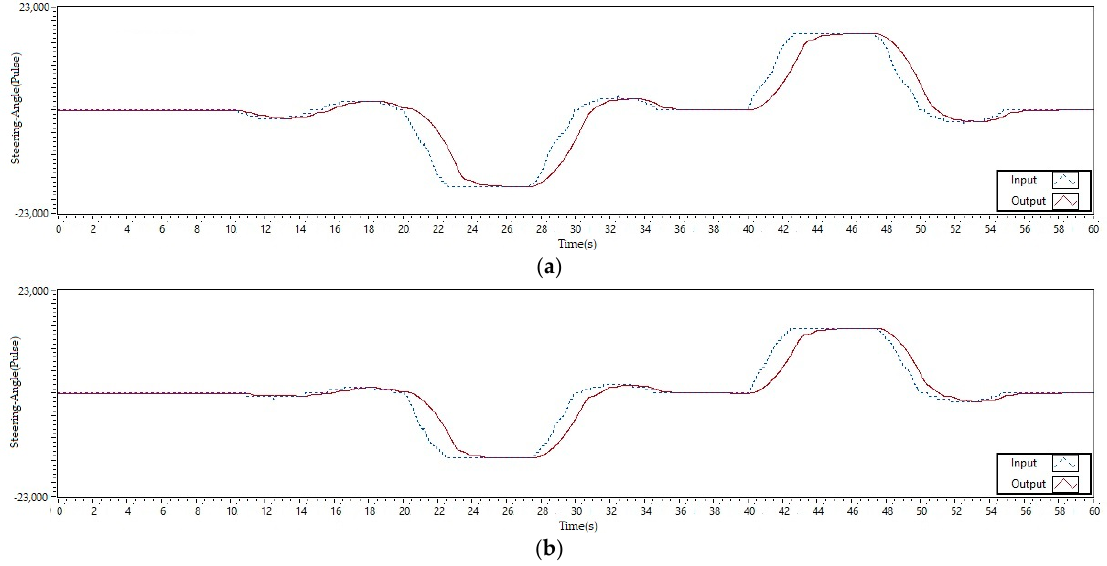
Figure 13. System output ( a ) using type-1 FLC and PI control and ( b ) using type-2 FLC and PI